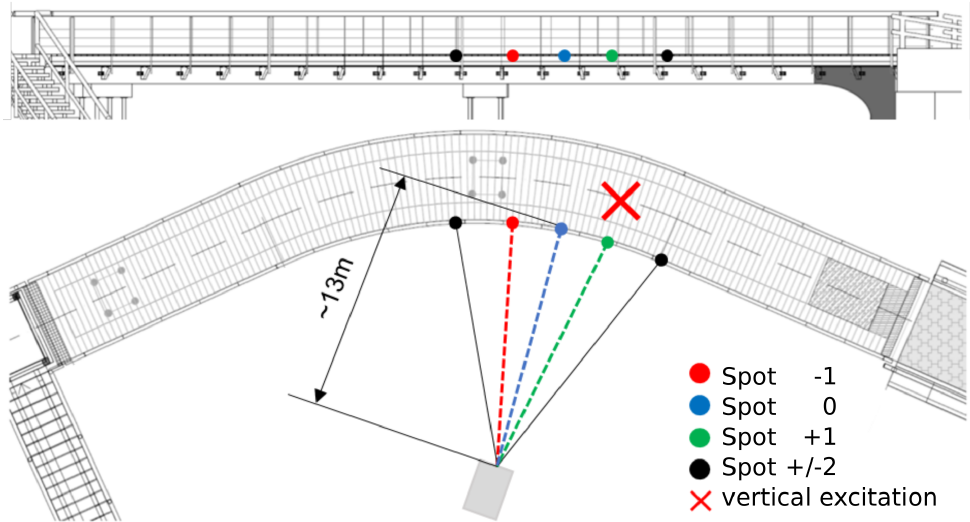
Figure 5. Outdoor setup for the bridge oscillation measurement. The distance of the camera to the central emitter is ≈ 13m. The red cross marks the spot where vertical force excitation was applied dynamically by jumping. Spot − 2 through + 2 correspond to the − 2nd − 1st, 0th, + 1st and + 2nd diffraction